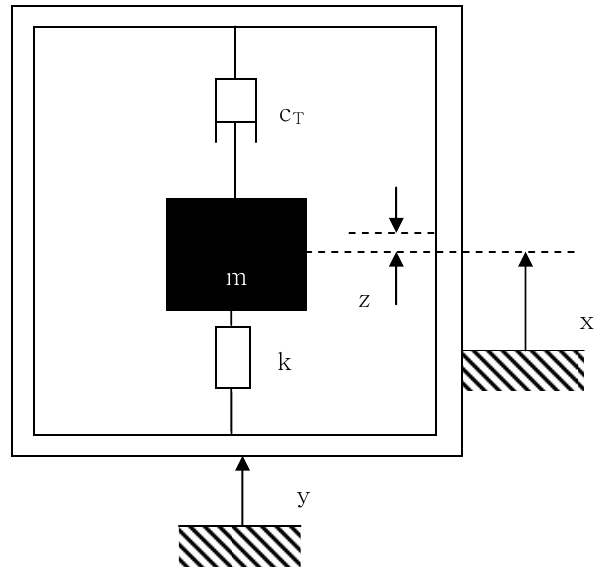
Figure 2. Diagram of a spring-mass-damper base excitation